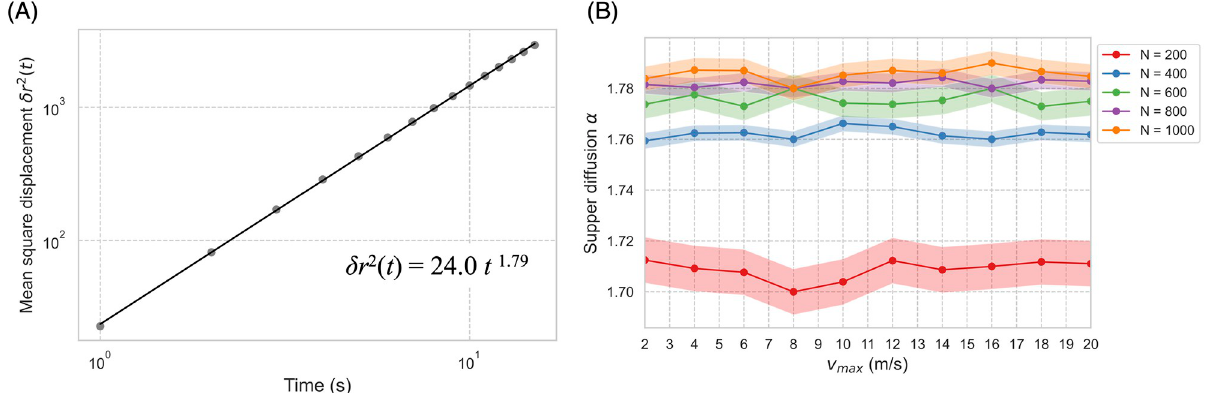
Fig 6. Super diffusion. (A) Mean square displacement in the center-of-mass reference frame. The diffusion coefficient D = 24.0, the diffusion exponent α = 1.79, the group size N = 1000, and the velocity parameter v max = 8 (m/s). (B) The α results obtained for different v max and N ; hence, α depends on N but not on v max